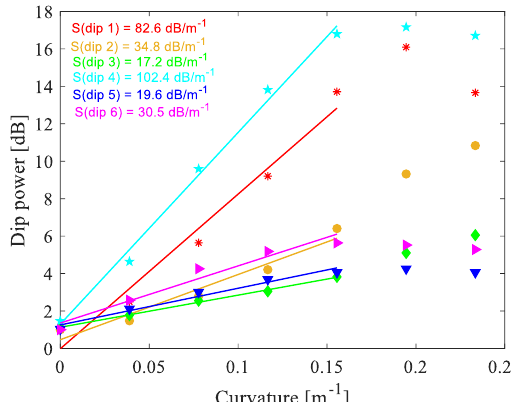
Fig. 3 . Dip power of the resonance bands that appear in Fig. 2, as function of the applied